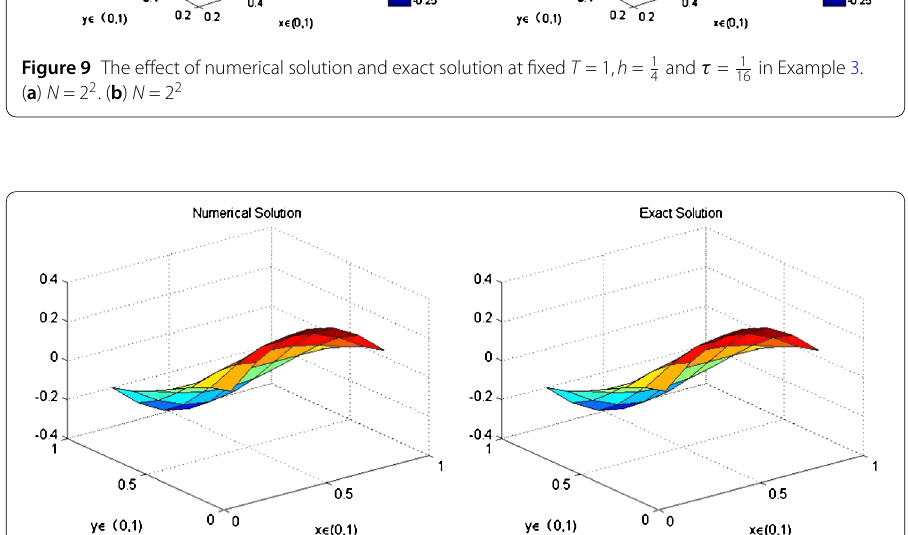
Figure 10 The effect of numerical solution and exact solution at fixed T = 1, h = 1 ( a ) N = 2 3 . ( b ) N = 2 3